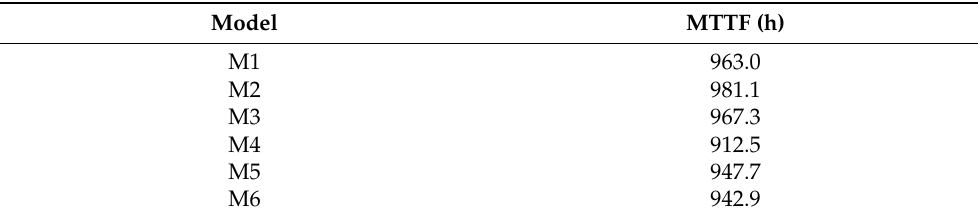
Figure 14. Failure probability distribution functions for three different models. Table 8. Comparisons of the MTTF for different reliability estimation models. Model